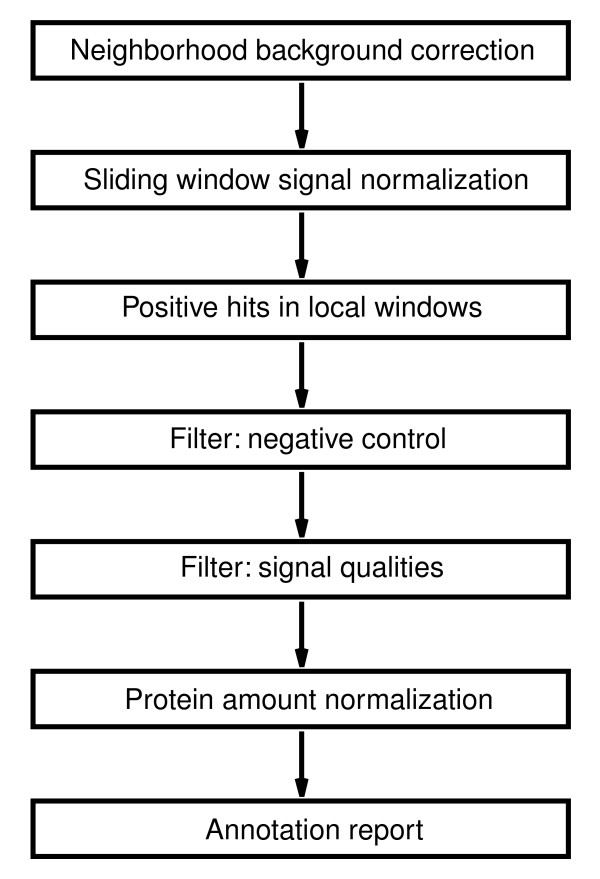
Flowchart of ProCAT. Six modules for reduction of specific array artifacts plus a report annotation module are implemented in order in the current version of ProCAT. The modular design and flexible stringencies allow the application of this approach to different functional protein microarray experiments.